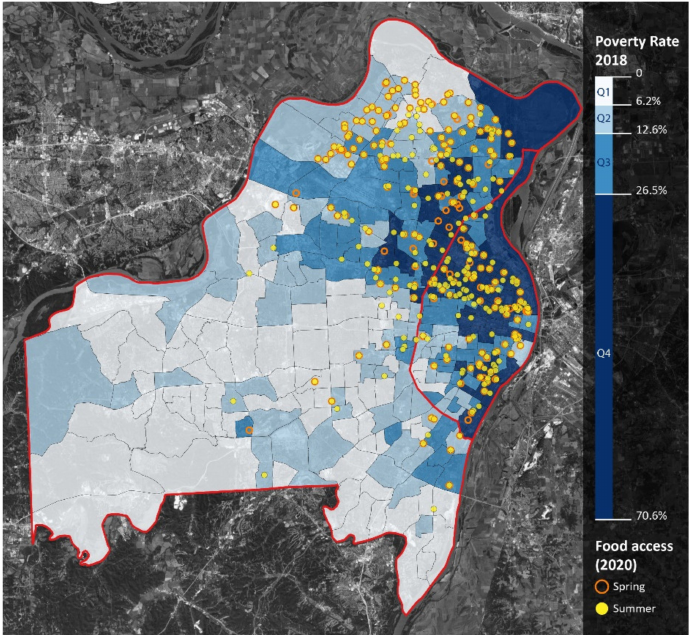
Figure 8. Poverty rate (in quartiles) and meal access. Notes: St. Louis City is the area east of the red line. St. Louis County is the area west of the red line. Darker blue shades represent greater proportions of residents in poverty. Orange circles represent spring meal sites; yellow dots represent summer meal